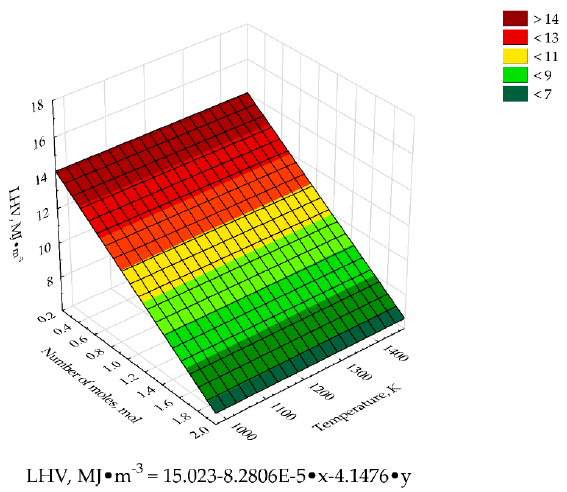
Figure 5. The effect of the number of moles of the gasification agent carbon dioxide (x) and temperature (y) on the heating value ( LHV ) of syngas.